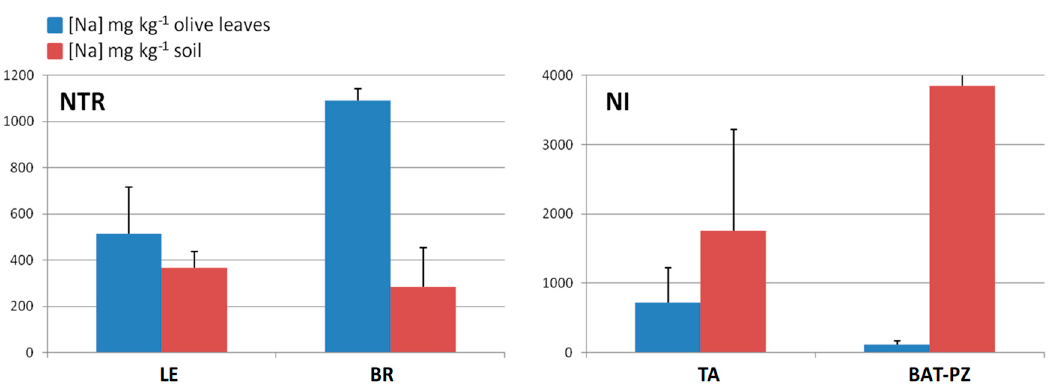
Figure 5. Mean concentration of sodium (Na, mg kg − 1 ) within olive tree leaves obtained for infected-not treated (NTR) and not-infected (NI), and the corresponding soil sample sites.